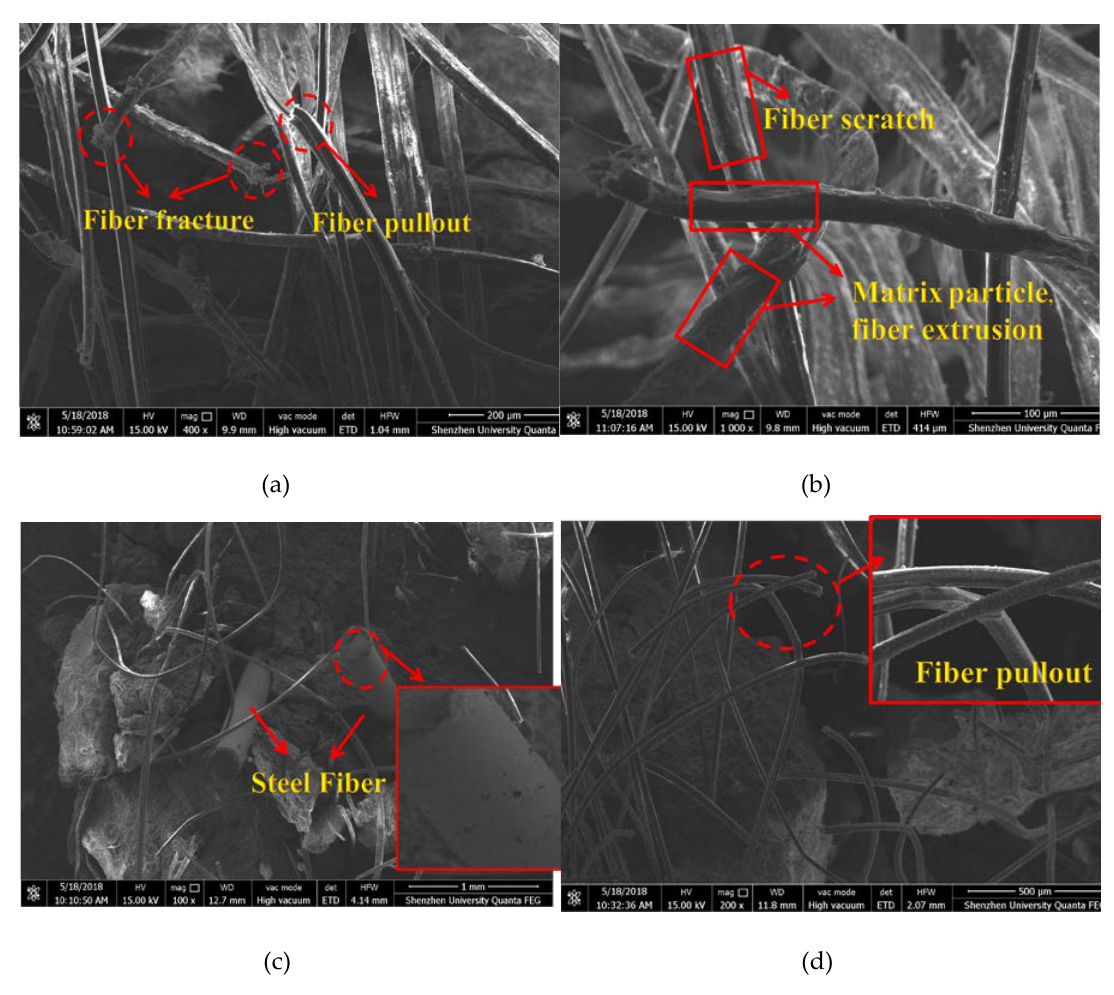
Figure 17. Environmental scanning electron microscopy (ESEM) images of PE and ST fiber and the